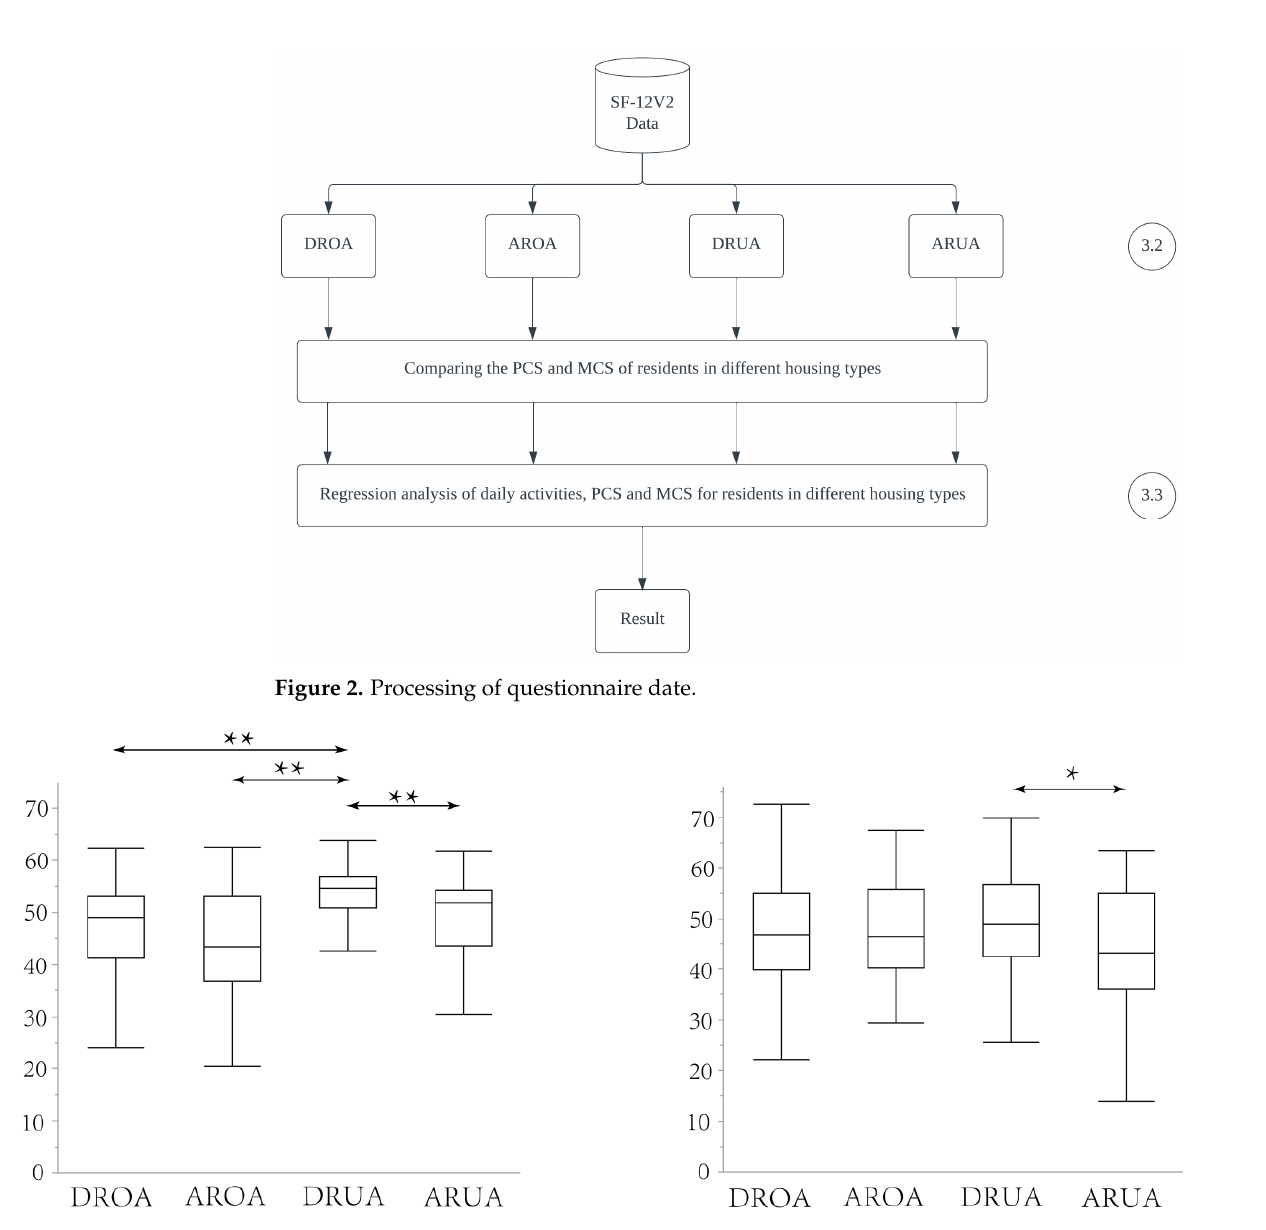
Figure 3. PCS and MCS (* p < 0.05, ** p < 0.01).